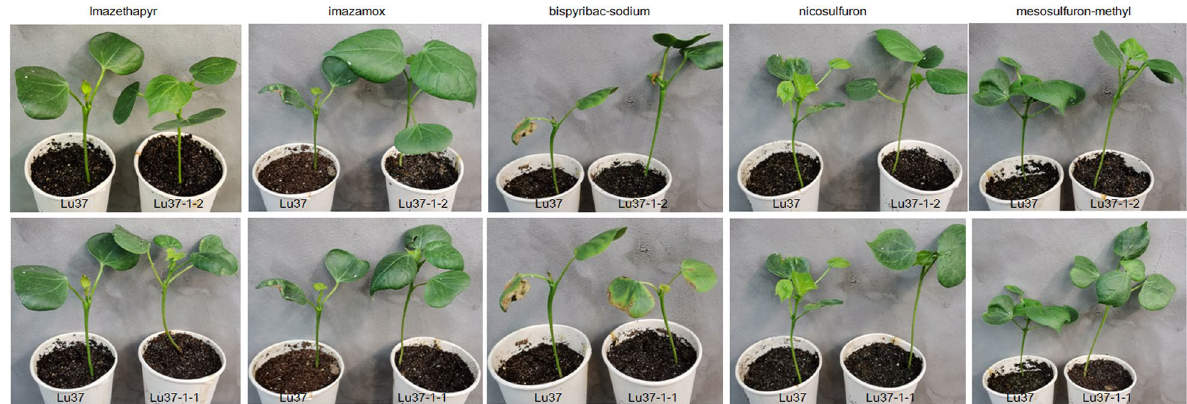
Fig. 3 Tests of the herbicide response of the Lu37-1 cotton mutant (M 5 generation) to other ALS-inhibitor herbicides under greenhouse growth condition. The herbicide-tolerant Lu37-1 and the wild-type Lu37 seedlings were sprayed with 3 herbicides. Photos were taken at 26 DAT